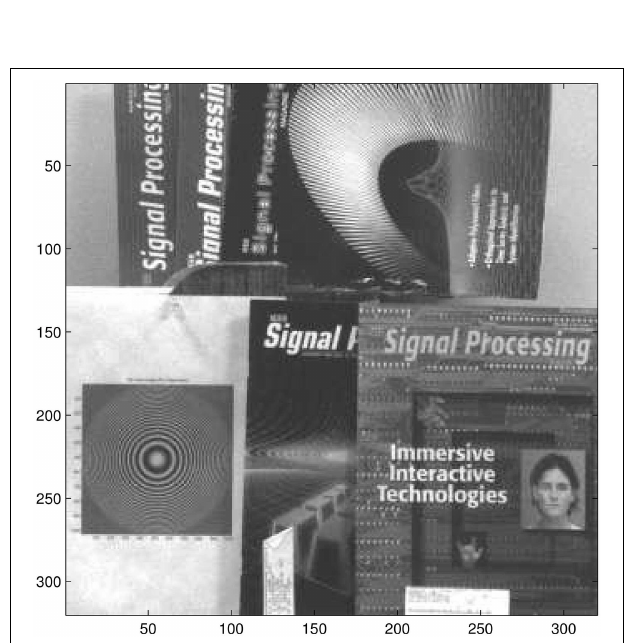
FIGURE 14 | The first LR frame (data set I) which has been captured by an 8 bit gray-scale Imaging Source camera (DMK 23U618) in our University of Dayton Image Processing Laboratory.